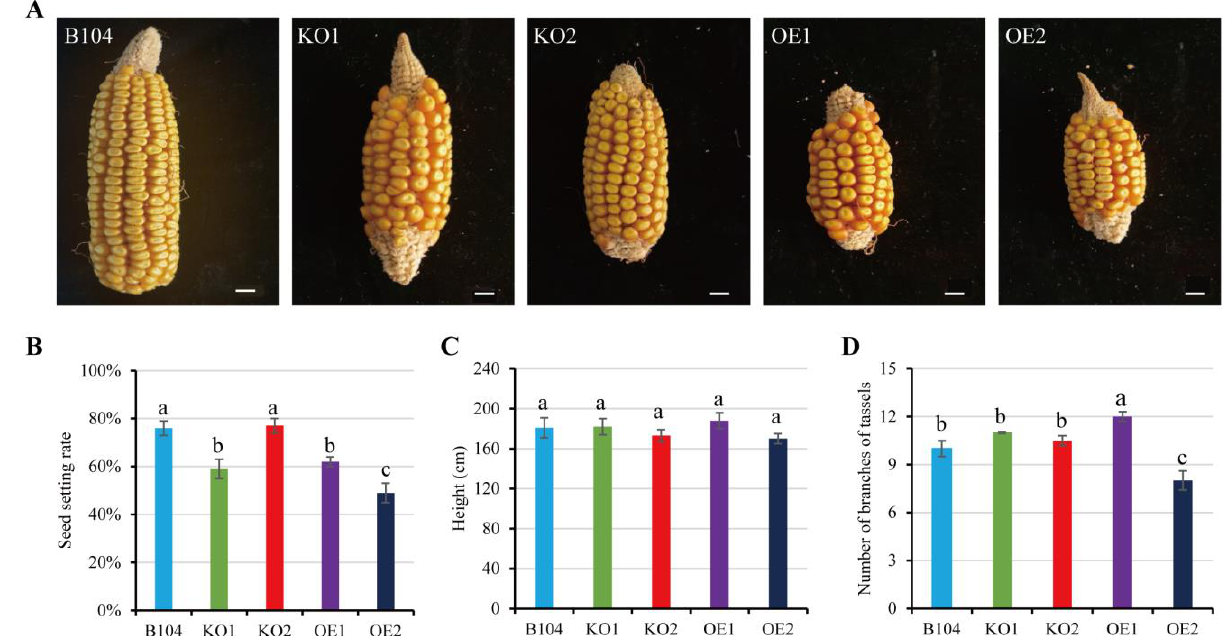
Figure 7. Comparison of plant height, branch number of tassels and kernel setting rate among WT and transgenic maize. ( A ) Representative mature female ears. Scale bar: 1 cm. ( B ) Seed setting rate. ( C ) Plant height. ( D ) Number of branches of tassels. Data represent means ± SD of three biological replicates. Significant differences are indicated with different letters ( p < 0.05, one-way ANOVA, Duncan’s multiple range test).